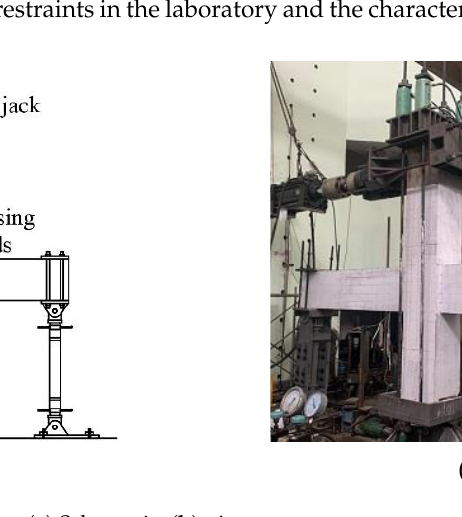
0.75%, 1%, 1.5%, 2%, 2.75%, 3.5%, 4.25%, and 5%. The loading procedure was terminated when the peak strength of a loading cycle dropped by 20% of the maximum strength.